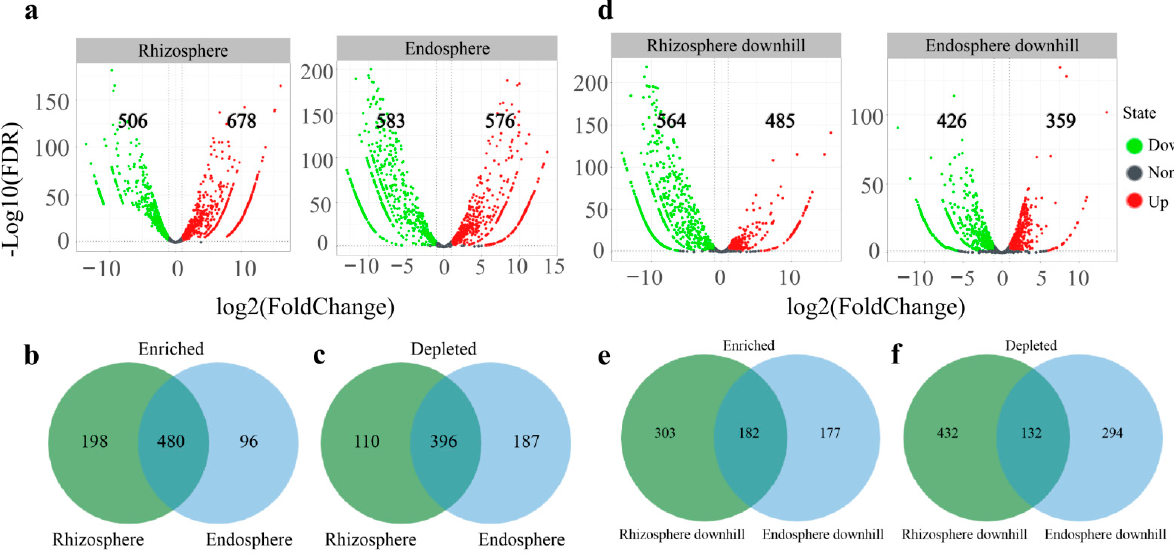
Figure 4. The enriched and depleted OTUs in the root endosphere, rhizosphere, downhill endosphere, and downhill rhizosphere. ( a ) Bulk soil was used as the control for differential abundance analysis. Enriched and depleted OTUs of the rhizosphere and endosphere compared with the bulk soil. ( b ) The number of differentially enriched OTUs between the root endosphere and rhizosphere. ( c ) The number of differentially depleted OTUs between the endosphere and rhizosphere. ( d ) Uphill rhizosphere and the root endosphere were used as controls for differential abundance analysis. Enriched and depleted OTUs of the rhizosphere downhill and endosphere downhill compared with the uphill rhizosphere and the root endosphere. ( e ) The number of differentially enriched OTUs between the downhill rhizosphere and endosphere. ( f ) The number of differentially depleted OTUs between the downhill rhizosphere and endosphere. Each point represents an individual OTU; the position along the X-axis represents the abundance fold change compared with bulk soil, and the Y-axis represents the − log 10 (FDR) obtained by correcting the p -value of the significant difference. The closer the point to the top of the graph, the more significant the difference